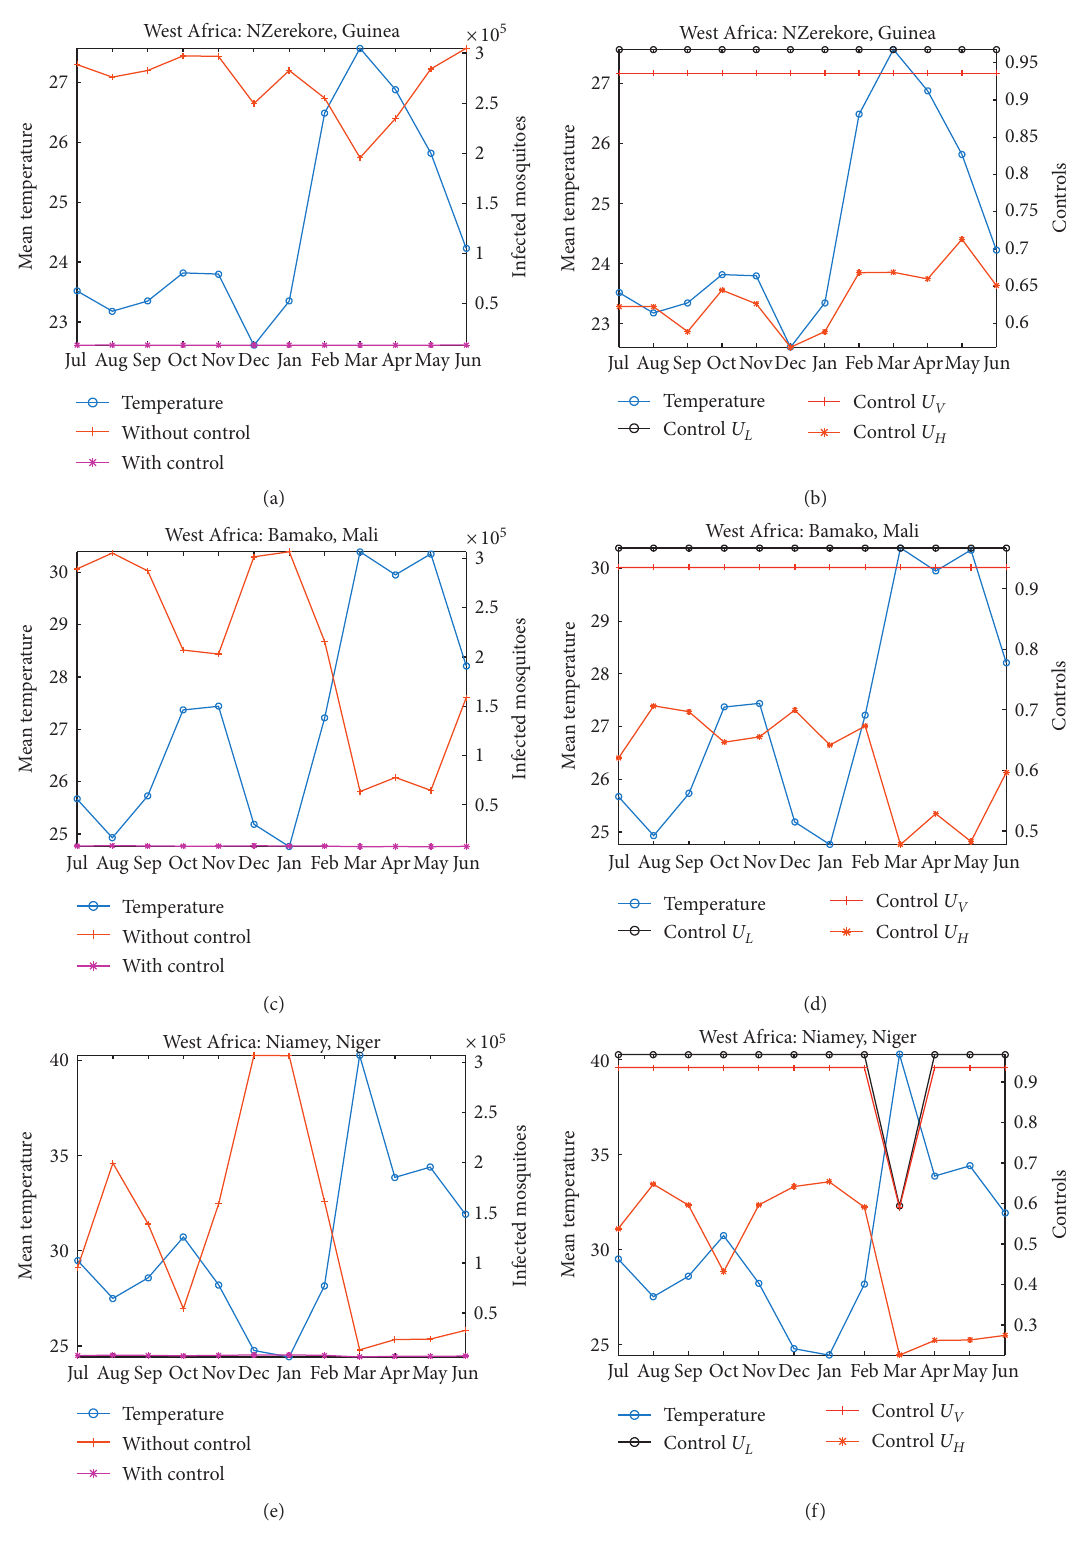
Figure 8: Simulations of the model (2) as a function of time: (a, c, e) the monthly total number of infected mosquitoes without and with control and (b, d, f) optimal controls u H ( t ) , u L ( t ) , and u V ( t ) , in NZerekore, Guinea; Bamako, Mali; and Niamey, Niger; in West Africa. The mean monthly temperature is plotted in blue lines and is superimposed onto each